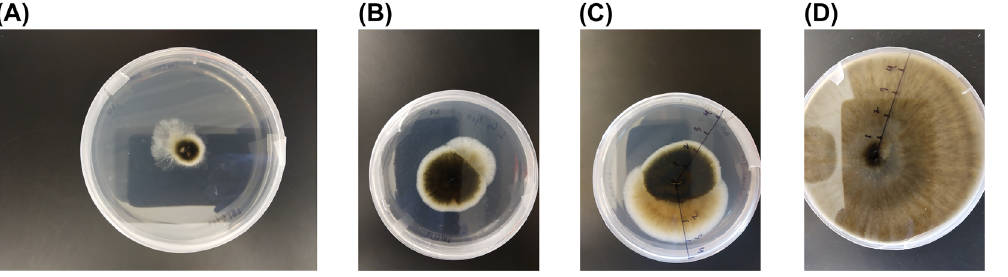
Figure 6: Growth of Alternaria alternata in Petri plates showing the mycelial growth inhibition. (A) Growth at concentration of 0.6 mg/mL, (B) growth at a concentration of 0.4 mg/mL, (C) growth at a concentration of 0.2 mg/mL, (D) growth in control set showing no inhibition in growth of the